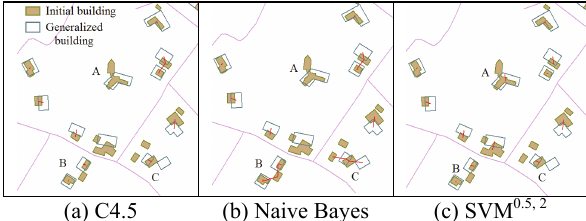
Figure 4: Matching examples predicted for sample set A by training from set B (links are shown in red between initial and generalized